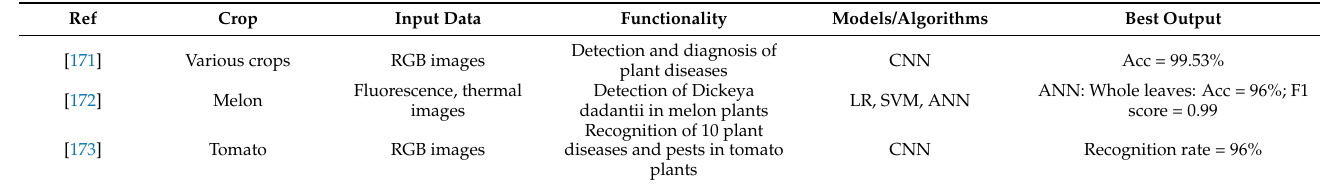
Table A2. Crop Management: Disease